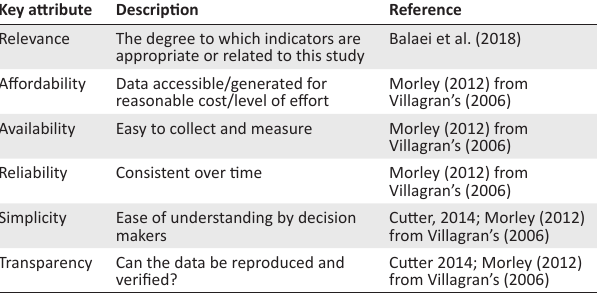
TABLE 2: Key attributes for assessing economic resilience